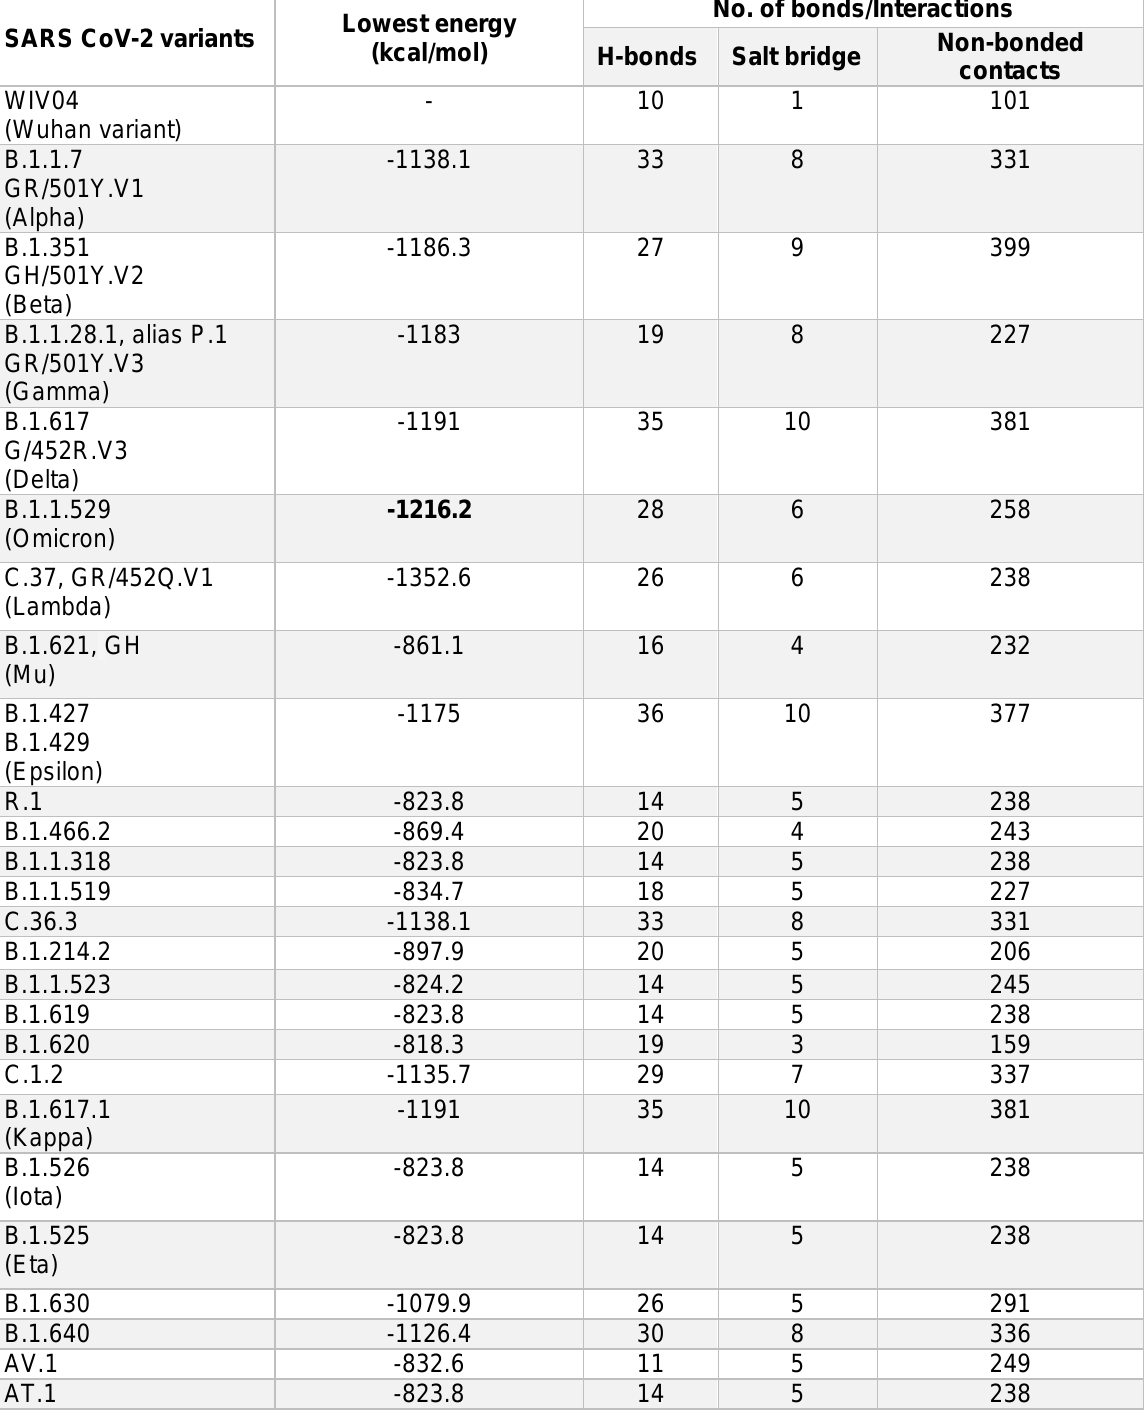
Table 1: Lowest energy and interactions of RBD of SARS-CoV-2 variants with